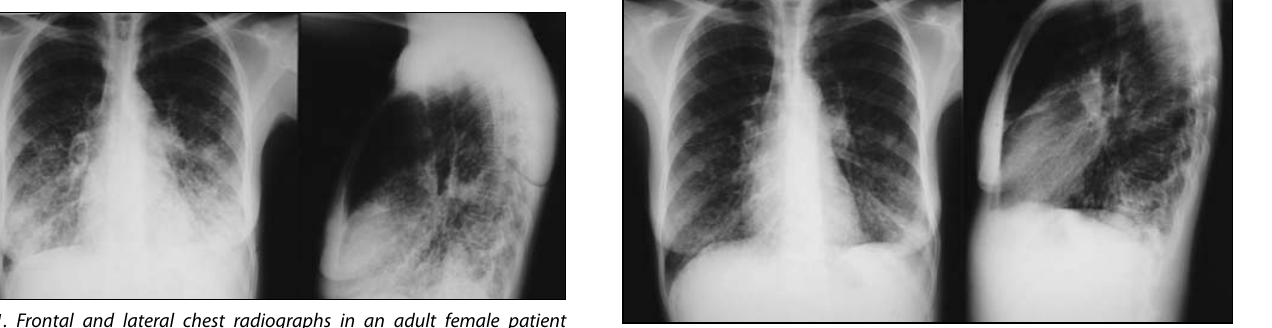
Fig. 3. Frontal and lateral chest radiographs demonstrate coarse reticular and nodular infiltrate in the mid and lower lung zones, with associated hilar adenopathy and left basal